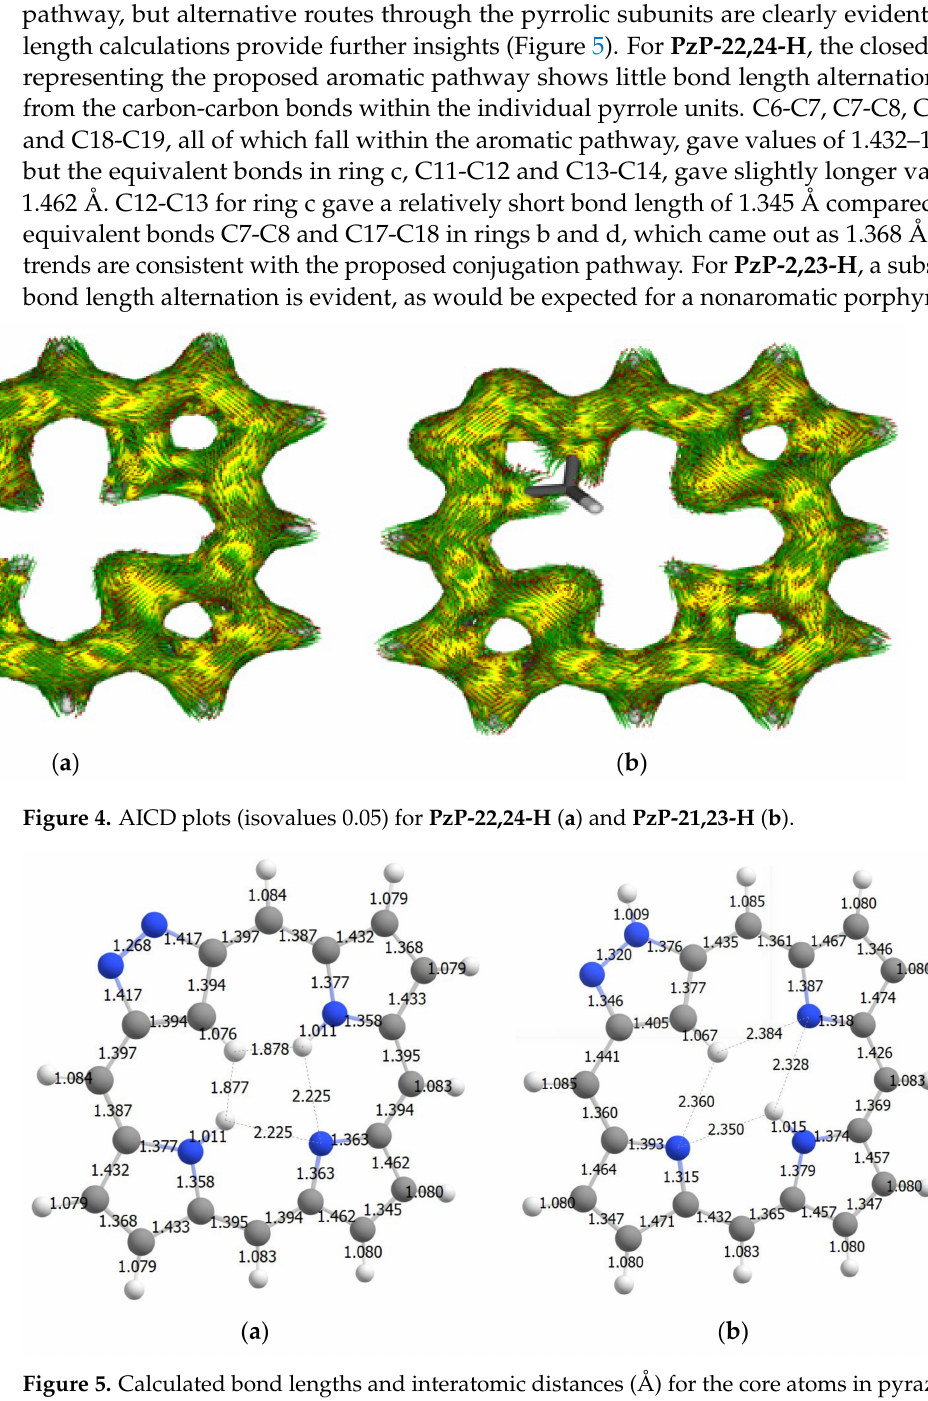
Figure 5. Calculated bond lengths and interatomic distances (Å) for the core atoms in pyrazolopor- phyrin tautomers PzP-22,24-H ( a ) and PzP-2,23-H ( b